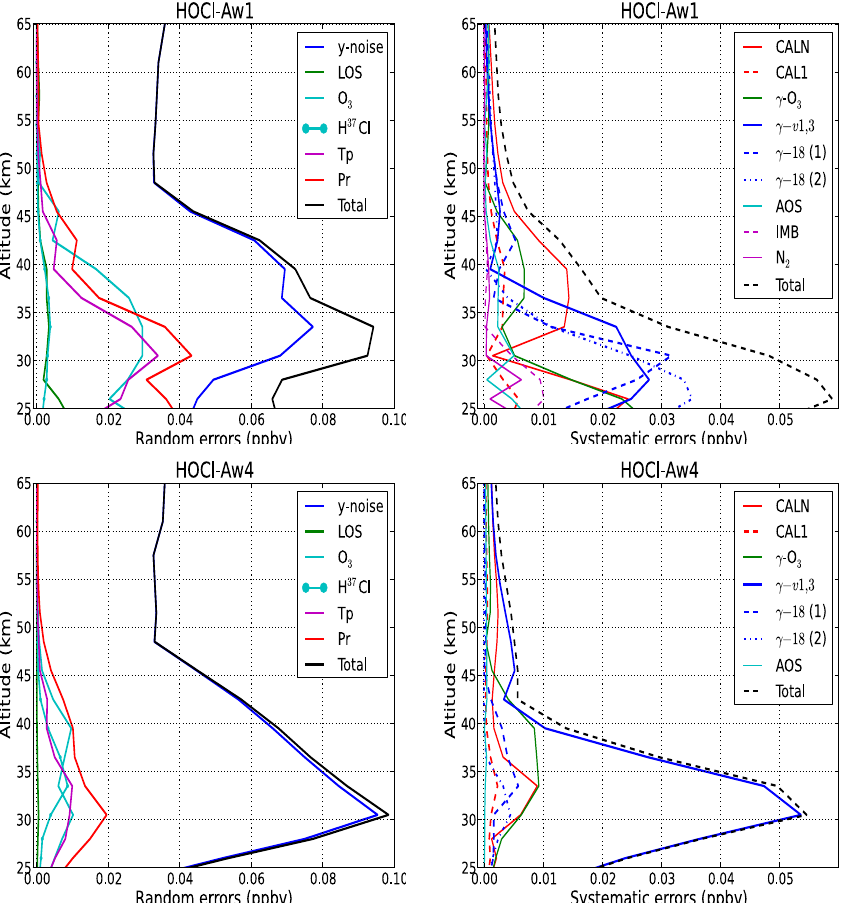
Fig. 15. Upper row: random (left panel) and systematic (right panel) errors on the HOCl profile retrieved from window A/B-w1. Lower row: Same for the HOCl profile retrieved from A-w4 or B-w3. The meaning of the labels on the systematic errors and the assumed errors on the parameters are given in Table